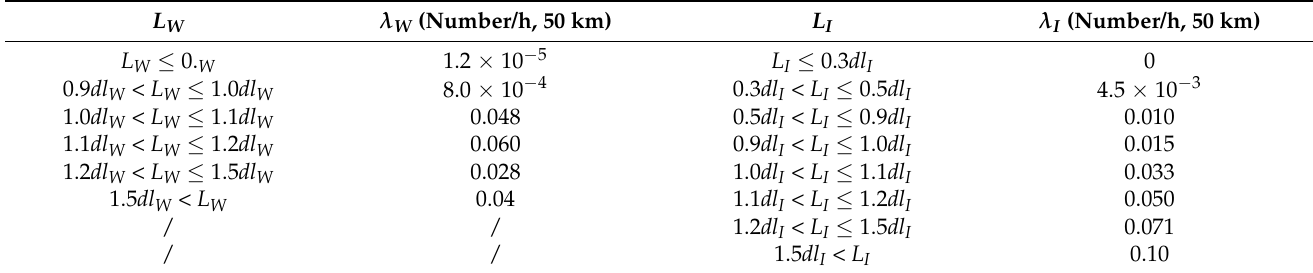
Table 3. Failure rate function of ice and wind load.